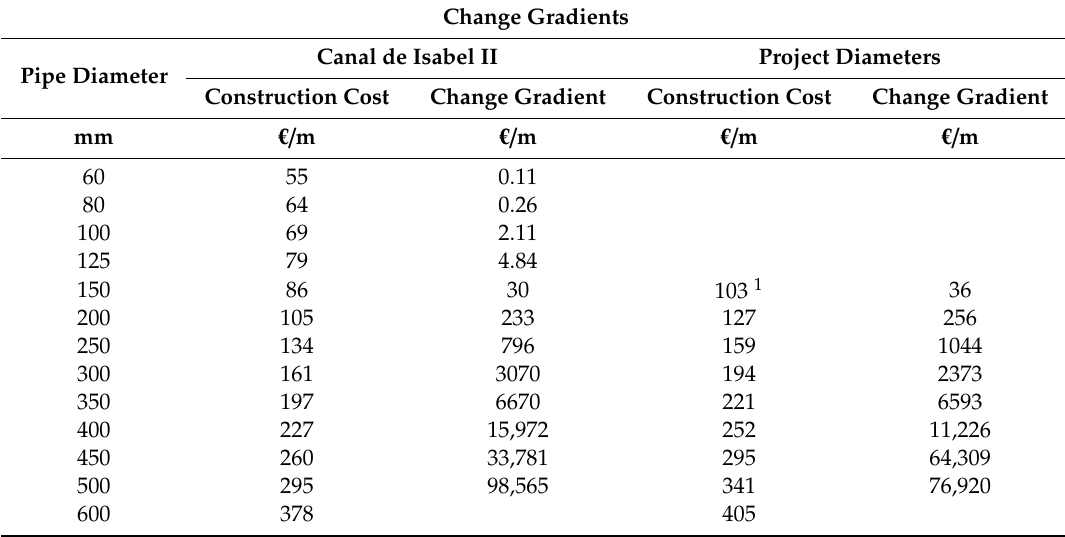
Table 2. Pipe prices series and change gradients